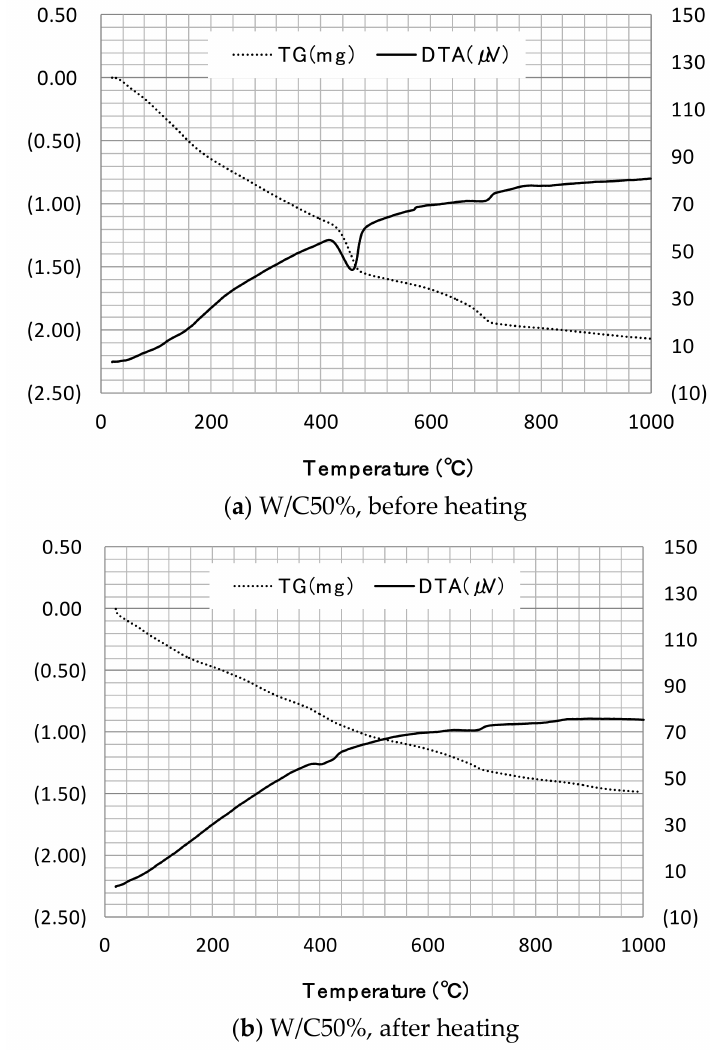
Figure 11. Thermal weight/differential thermal simultaneous analysis (TG-DTA)